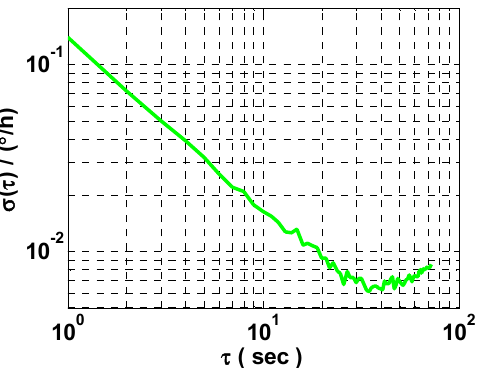
Figure 6. AVAR result of the resultant gyro noise difference data of x and z constant rate biased RLGs when the turntable rotates at 40°/s.